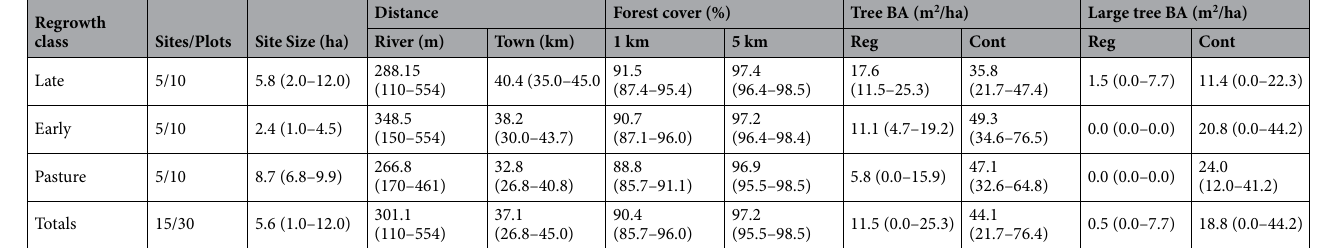
Table 2. Summary of survey locations. Characteristics of 15 sites used to study forest structure. Values are means with ranges in